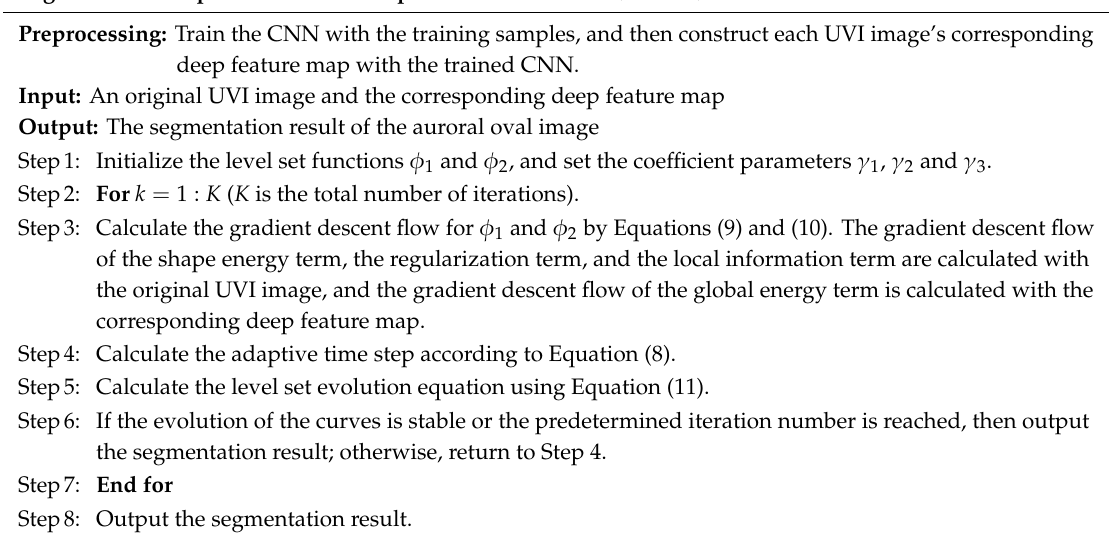
Algorithm 1. Deep feature-based adaptive level set model